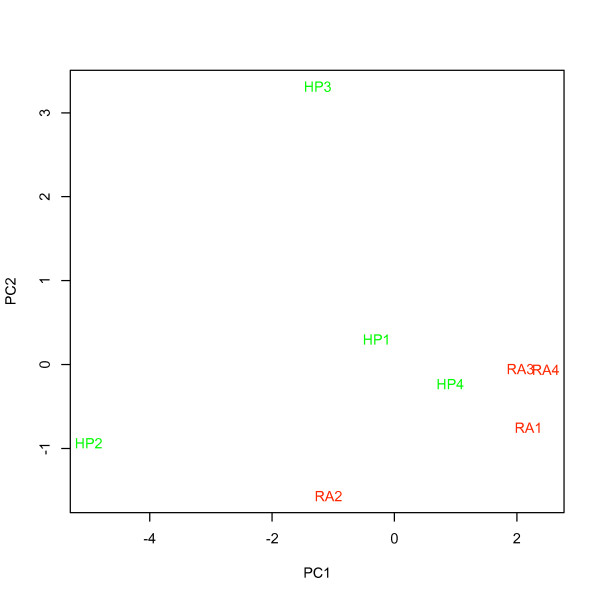
PCA for a 12 gene signature for prognosis in NSCLC in hybridizations using RNA prepared from four tumor samples using both the HighPure (Roche) and RecoverAll (Ambion) RNA extraction kits for FFPE studies. "HP" (green) represents samples extracted using HighPure (Roche), and, "RA" (red) represents the same samples extracted using RecoverAll (Ambion).